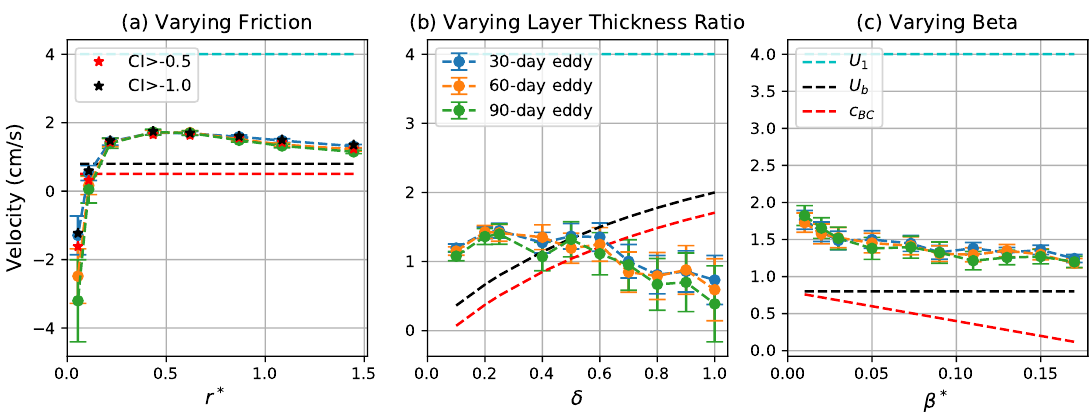
Figure 9. Zonal propagation velocity of coherent eddies as a function of ( a ) r ∗ , ( b ) δ , and ( c ) β ∗ . Blue, orange, and green curves correspond to the mean of the zonal propagation velocity for 30-, 60-, and 90-day eddies, respectively. Error bars give two times the standard error of the mean. Red and black stars in the left panel indicate the mean for 30-day eddies detected by varying the CI threshold to − 0.5 and − 1.0, respectively. The dashed cyan, black and red lines give the upper layer mean flow U depth-averaged mean flow U b , and baroclinic Rossby wave speed c BC ,